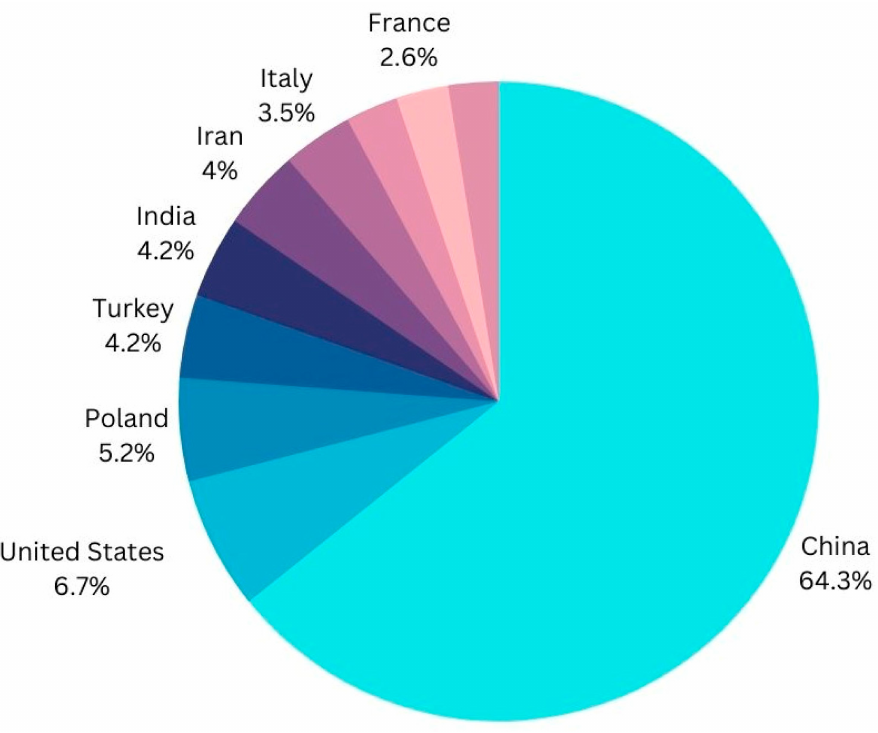
Figure 3. Universal Most and Least production rate of Apple